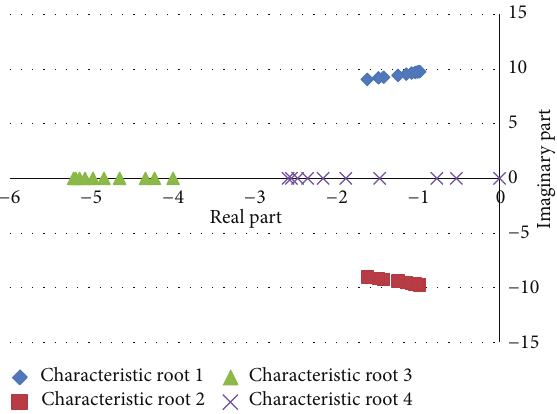
Figure 5: Characteristic roots of Jacobian